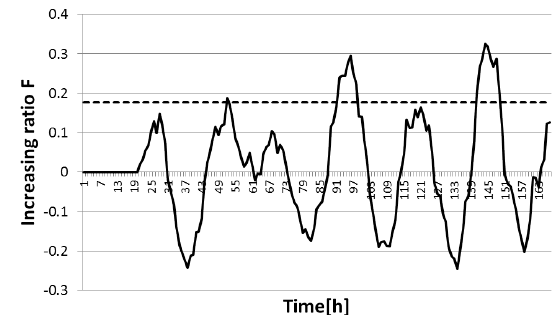
Figure 12: Number of detections for signature num- ber 11.